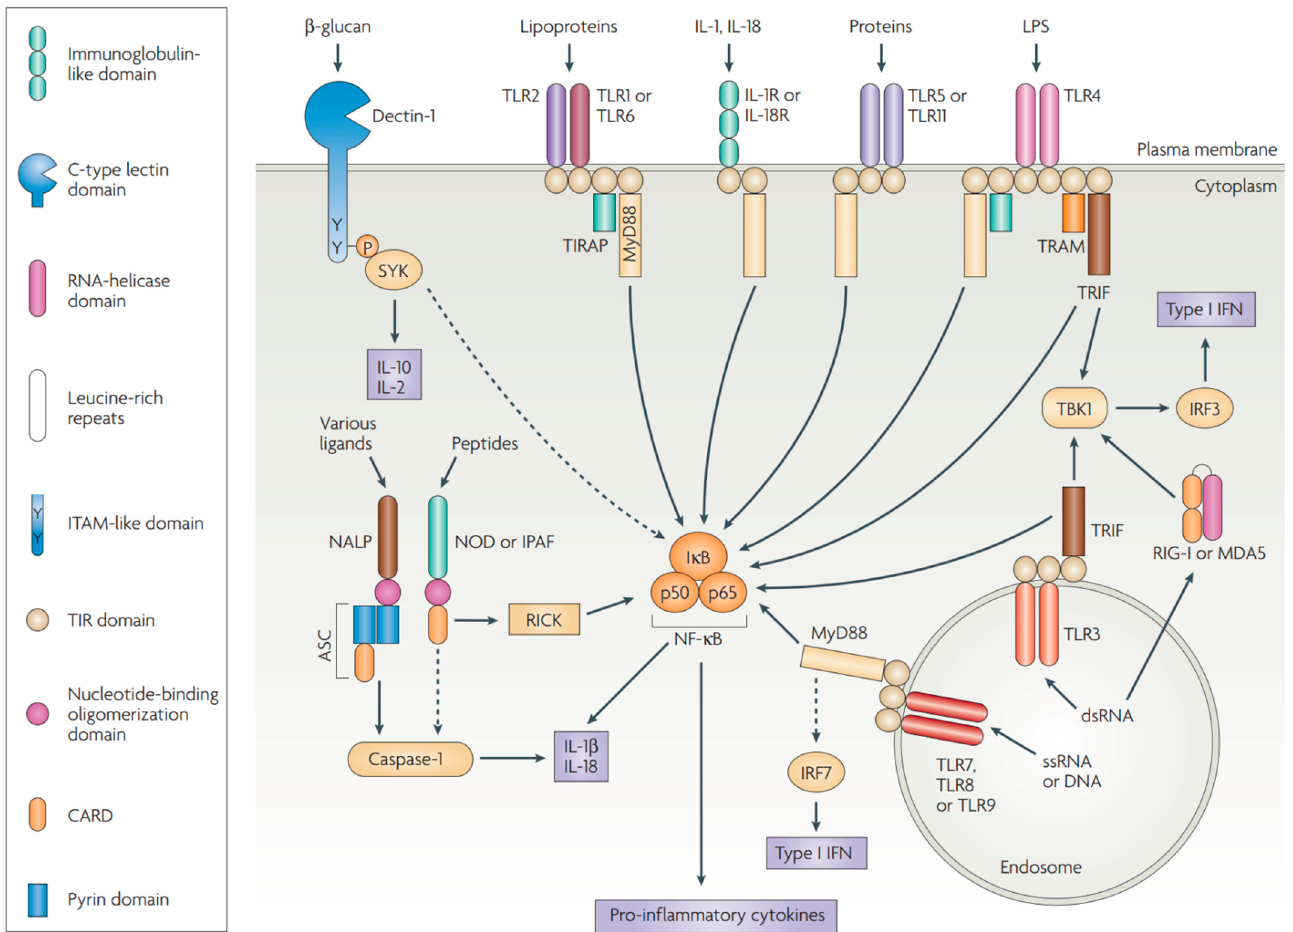
Figure 3. Schematic representation of the structure and main signaling pathways of the PRR fami- lies. Only the adaptor molecules and the main signaling pathways that differentiate the different classes of PRR are shown. Dectin-1 (a β -glucan receptor) is shown as an example of various cell- surface PRRs, some belonging to the lectin-like family, and some linked with the immunoreceptor tyrosine-based activation motif (ITAM)-containing adaptor Fc receptor γ -chain (FcR γ ), the activa- tion of which can markedly affect TLR signaling. ASC, apoptosis-associated speck-like protein con- taining a CARD (caspase-recruitment domain); ds, double-stranded; IFN, interferon; I κ B, inhibitor of NF- κ B; IL, interleukin; IPAF, ICE-protease-activating factor; IRF, IFN-regulatory factor; LPS, lip- opolysaccharide; MDA5, melanoma-differentiation-associated gene 5; MyD88, myeloid differentia- tion primary-response gene 88; NALP, NACHT-, LRR- and pyrin-domain-containing protein; NOD, nucleotide-binding oligomerization domain; RICK, receptor-interacting serine/threonine kinase; RIG-I, retinoic-acid-inducible gene I; ss, single-stranded; TBK1, TANK-binding kinase 1; TIRAP, Toll/IL-1R (TIR)-domain-containing adaptor protein; TRAM, TRIF-related adaptor molecule; TRIF, TIR-domain-containing adaptor protein inducing IFN β ; SYK, spleen tyrosine kinase. Adapted with permission from [149]. Copyright 2007, Springer Nature.